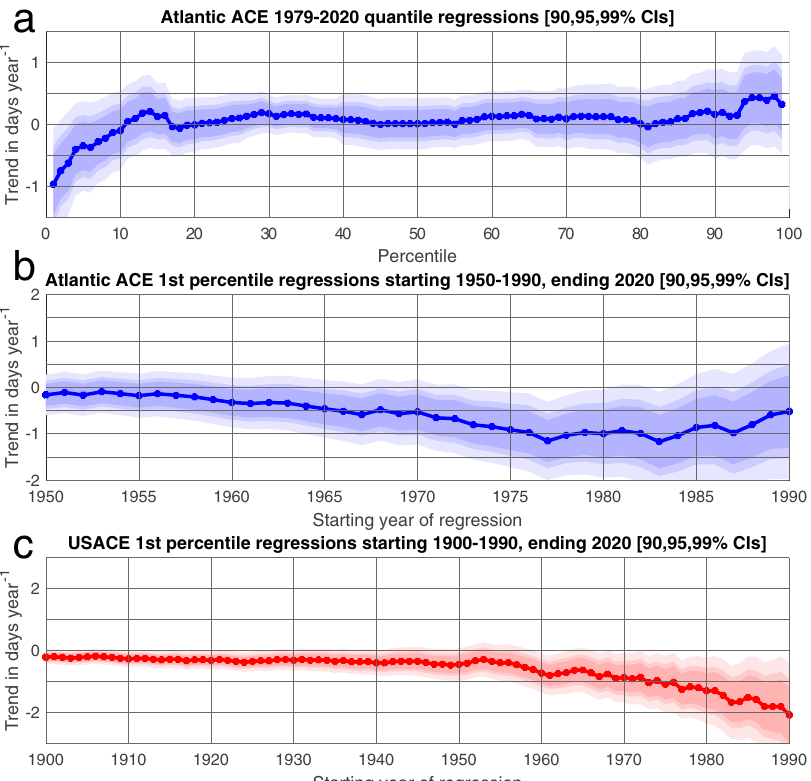
Fig. 1 Quantile regressions of Accumulated Cyclone Energy (ACE) and ACE over the continental United States (USACE) with year. a Trend in days year − 1 for Atlantic ACE 1st – 99th percentile threshold dates between 1979 – 2020. Light, medium, and dark blue shading designate 99%, 95%, and 90% con fi dence intervals. b Trend in days year − 1 of 1st percentile threshold dates of ACE for starting years 1950 – 1990 and ending year 2020. Shading as in Fig. 1a. c As in Fig. 1b, with USACE and starting years 1900 – 1990. Light, medium, and dark red shading designate 99%, 95% and 90% con fi dence intervals (Supplementary Table 1). For ACE, the corresponding implied